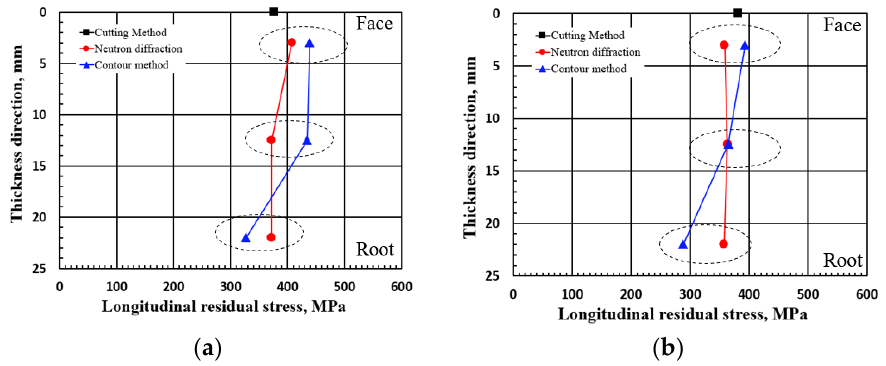
Figure 10. Weld residual stress σ x of constrained specimen using cutting, neutron diffraction, and contour methods. ( a ) Weld metal; ( b ) fusion line + 1 mm.